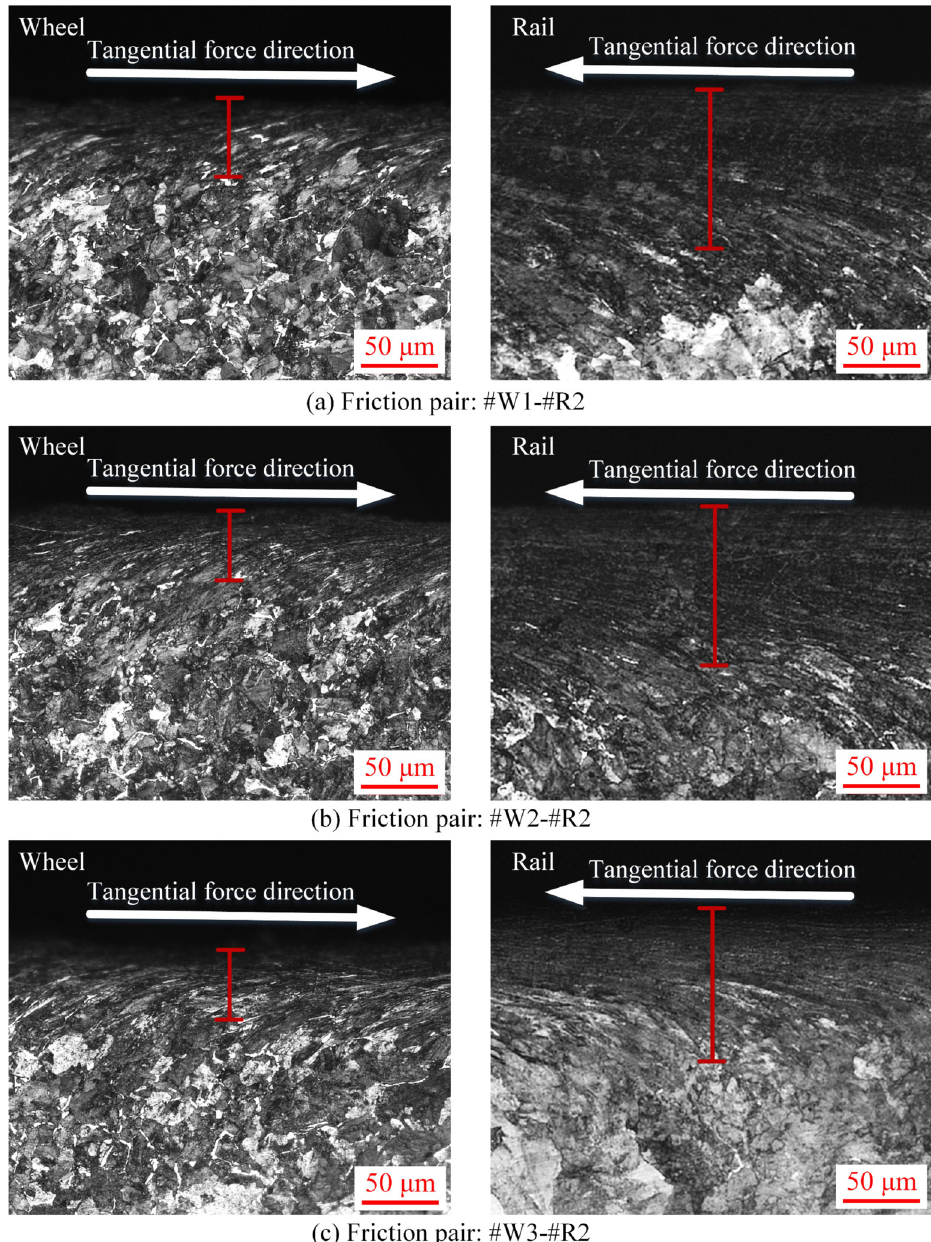
Figure 15. OM micrographs of subsurface plastic deformation of the wheel/rail discs under different friction pairs: ( a ) #W1-#R2; ( b ) #W2-#R2; ( c ) #W3-#R2.